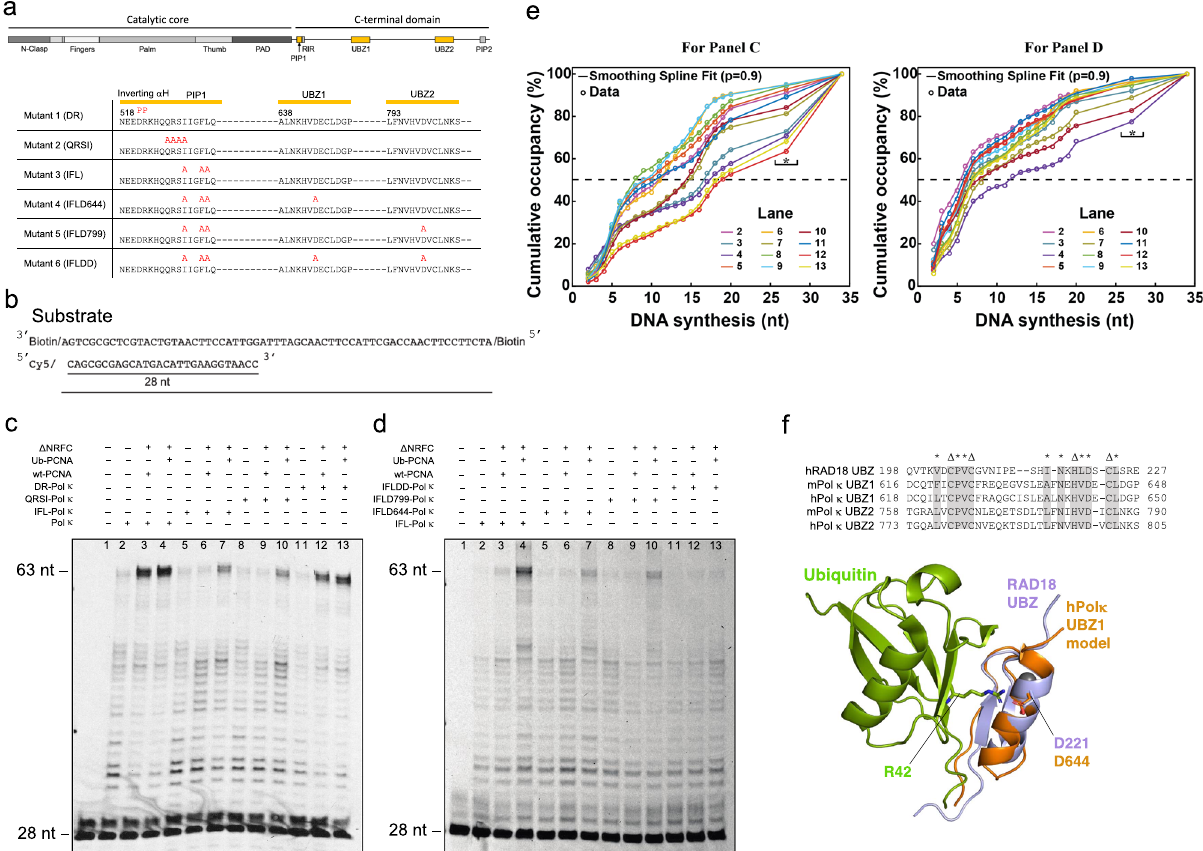
Fig. 5 Mutational analysis of the Pol κ synthetic activity. a Schematic view of the Pol κ mutants used in the primer extension assays. Mutated residues are colored red above the native sequence. b Schematic representation of the primer/template DNA substrate used in the assays. c , d Activity of Pol κ and stimulation by PCNA on the DNA substrate. Wild-type Pol κ and Pol κ mutants were incubated with the substrate in the presence and absence of PCNA at 30 °C for 40 s and the products were separated on 15% denaturing polyacrylamide gels at 12 W for 3 h. The reaction ’ s procedure is detailed in the “ Methods ” section. Experiments have been repeated at least two times. e Plots of the cumulative percentages of DNA synthesis up to the indicated number of synthesized nucleotides constructed from the lanes of the gels presented in panels ( c ) and ( d ), respectively. The curves were generated as described in the “ Methods ” section. The experimental data points (circles) were fi tted to relatively rough smoothing splines (solid lines) with the indicated smoothing parameter. The curves account exclusively for the distribution of the bands corresponding to DNA synthesis products and not for the remaining enzymatically unmodi fi ed substrate. In both graphs, the horizontal black dashed lines represent a median DNA synthesis value of 50%. The intersection of each smoothing spline fi t with this 50% line gives an N 1/2 value, which represents an apparent number of synthesized nucleotides up to which 50% of the total DNA synthesis is achieved. For both graphs, the experimental data points and their corresponding fi tting curves are color-coded as presented in the inset legend. In both graphs, the black star sign marks the values corresponding to 27 synthesized DNA nt to highlight that this value was not obtained directly but rather represents a summation of the smeared region between 21 and 33 nt following background subtraction. f (top) Alignment of the sequences of human Rad18-UBZ domains and Pol κ UBZ domains from mouse and human. Zinc-coordinating residues are labeled with Δ . Residues at the interface with ubiquitin are labeled with asterisks. Conserved residues by type are colored gray. (bottom) Homology model of human Pol κ UBZ1 aligned on the NMR structure of Rad18-UBZ/Ubiquitin complex (PDB ID 2MRE) 51 . Pol κ UBZ1 model was built with HHpred 95 based on the Rad18-UBZ/ubiquitin complex structure 51 . Residues involved in the salt bridge critical for UBZ/Ubiquitin complex formation are shown as possibility, we designed three Pol κ mutants containing mutations well as the association of Pol κ with replication factories in cells in both the internal PIP-box and in either one or both Pol κ UBZs exposed to UV radiation 45 . In our assay, the synthetic activity of Pol κ variants bearing mutations in the PIP-box and one of the (Fig. 5a). The UBZ mutation (D644A in UBZ1 and D799A in two UBZs (ILFD644 and ILFD799 mutants) with Ub-PCNA UBZ2) was selected based on the sequence conservation between (Fig. 5d, lanes 7 and 10, Fig. 5e and Supplementary Table 2) was the mouse and human Pol κ UBZ orthologs as well as the UBZ of reduced compared to the PIP-box mutant only (Fig. 5d, lane 4, human RAD18 (Fig. 5f). NMR studies showed that RAD18 UBZ Fig. 5e and Supplementary Table 2), while mutation of the PIP- binds ubiquitin with micromolar af fi nity through the ubiquitin box and both UBZs (Mutant IFLDD) resulted in minimal syn- hydrophobic patch centered on L8/I44/V70, and that the con- thetic activity (Fig. 5d, lane 13, Fig. 5e and Supplementary served aspartic acid C-terminal to the zinc-coordinating histidine Table 2). The effects of UBZ mutations are not observed when establishes a salt bridge with ubiquitin Arg42, which is critical for PCNA is not ubiquitylated, demonstrating that the interaction complex formation 44 (Fig. 5f). Consistently, previous biochemical data in mouse showed that alanine mutation of the conserved mediated by the UBZs is ubiquitin-speci fi c. To con fi rm a direct aspartate in both UBZs disrupted the association between Pol κ interaction between Pol κ UBZ1/2 and ubiquitin, we used NMR and ubiquitin, the association between Pol κ and Ub-PCNA, as and measured the chemical shift perturbations of 15 N-labeled